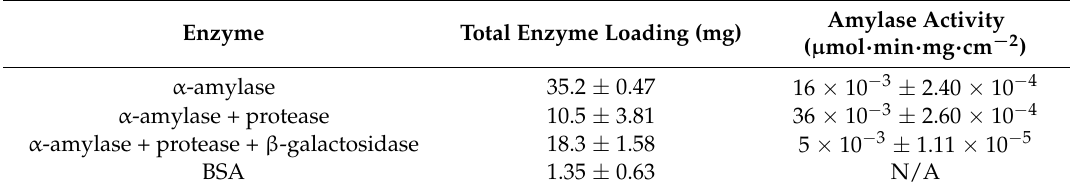
Table 2. Enzymatic activity of α -amylase immobilized on its own and in combination with β -galactosidase and protease on poly(styrene- co -maleic anhydride) nanofibrous mats (n = 3) .